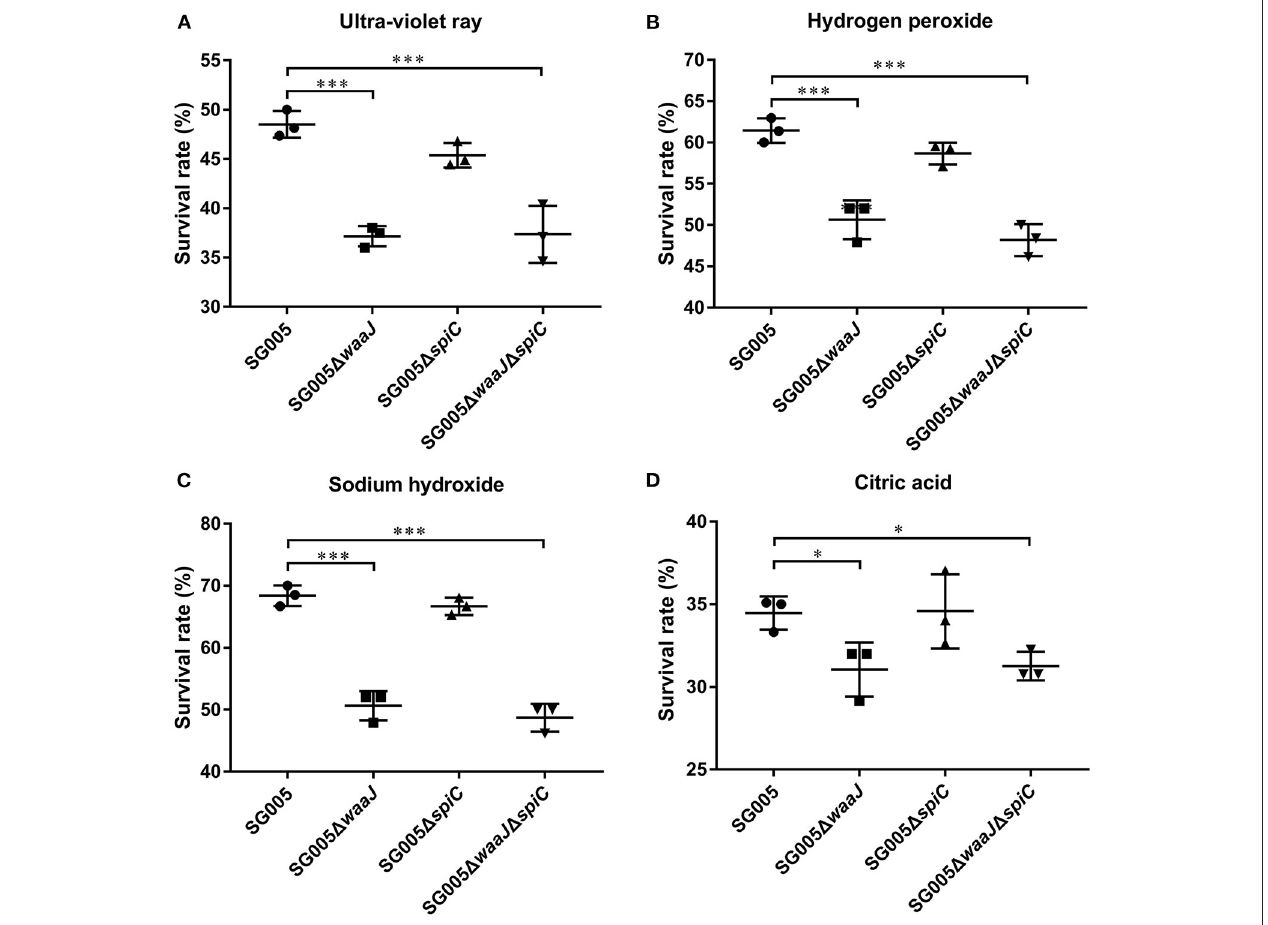
FIGURE 3 | Survival rates of SG005 and deletion strains in different environmental stresses. (A) UV irradiation for 1min. (B) Hydrogen peroxide (100 µ M for 5min). (C) Sodium hydroxide (12.5mM for 5min). (D) Citric acid (50mM for 20min). Statistical analysis was done using one-way ANOVA. * P < 0.05, ** P < 0.01, *** P < 0.001. Each experiment was repeated three times.